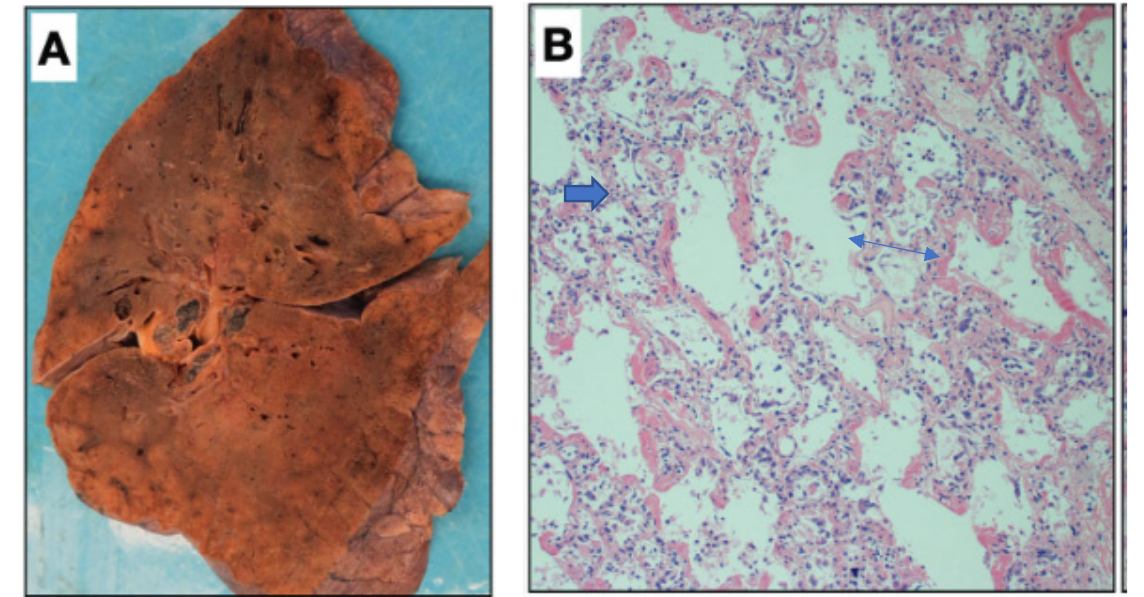
Figure 1. Macroscopic picture of a lung taken during a post-mortem autopsy of a patient who was admitted at the Mount Sinai Hospital and died because of SARS-CoV-2 infection. The gross appearance resembles that of a solid organ with “patchy” areas of consolidation ( A ). The microscopic picture ( B ) shows the “congestion” of the alveolar capillaries, which may represent the initial episode of the lung changes accompanied by fibrin deposits (blue arrow) of the article published by Bryce C et al. in Modern Pathology 2021; 34:1456–1467 [40]).